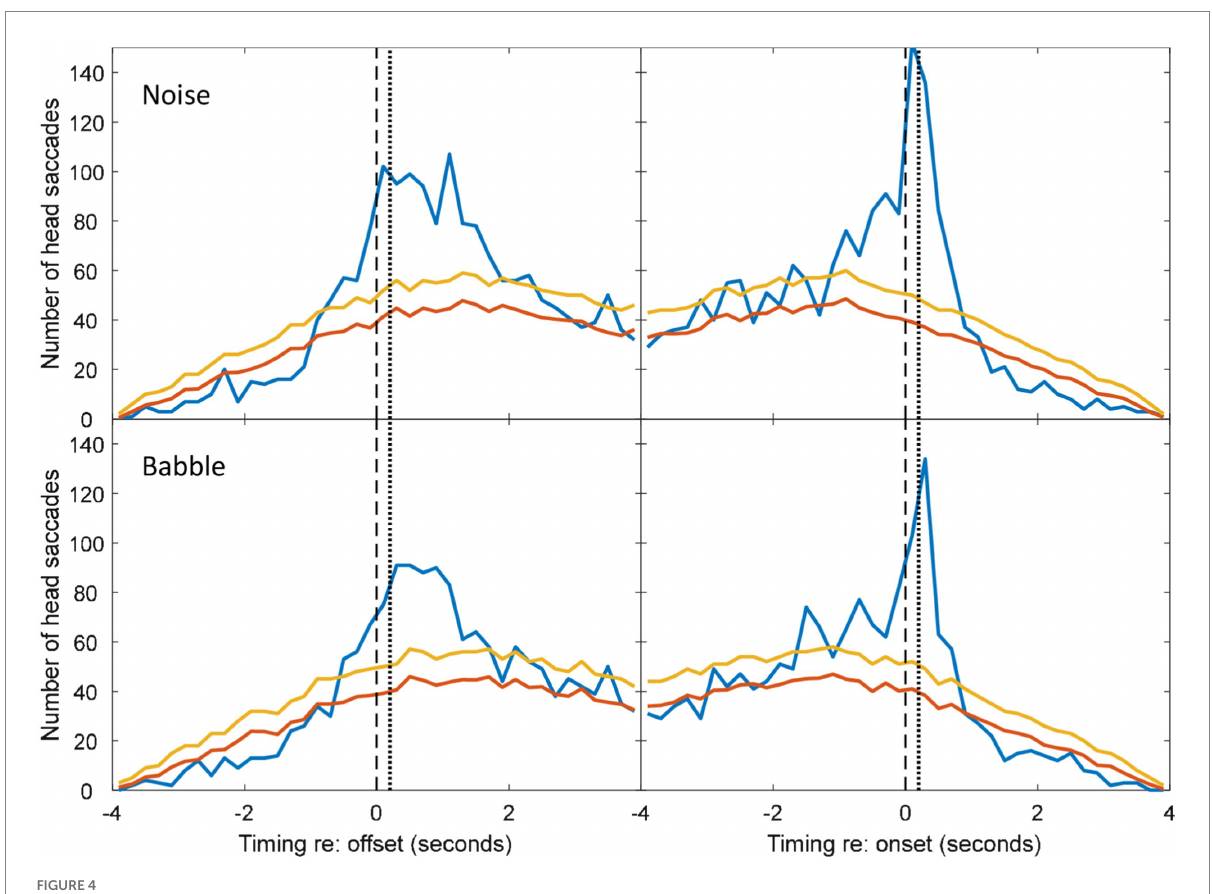
FIGURE 4 Histograms during non-overlapping utterances from Figures 2, 3.